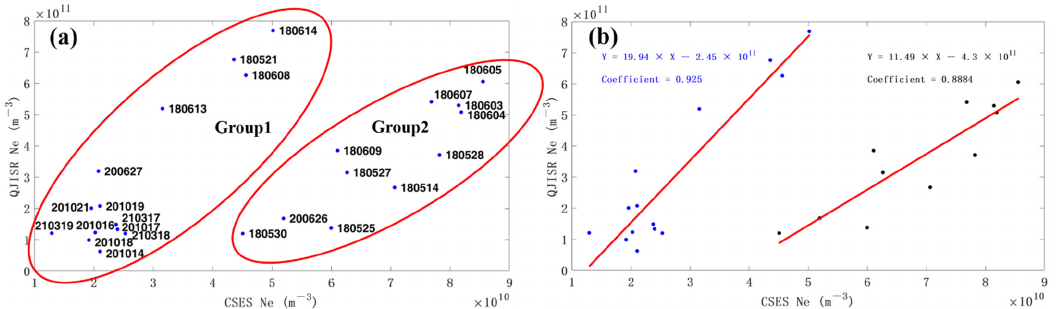
Figure 4. Ne scatters of CSES and QJISR with two groups (panel ( a )) and the fitting lines (panel ( b )). In panel ( a ), the number means the detailed date for each point with the format of YYMMDD. In panel ( a ), the data of groups 1 and 2 are represented by blue and black dots, respectively.